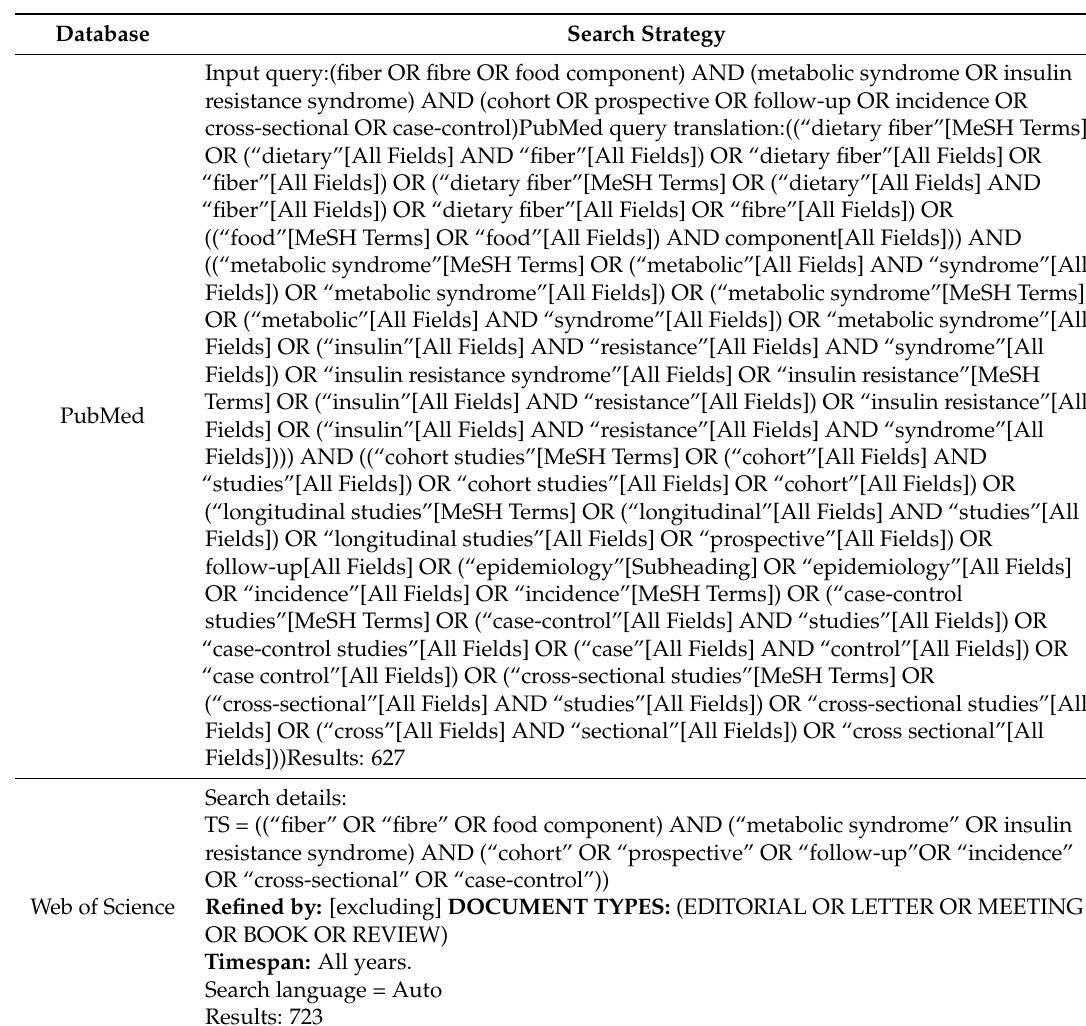
Table A1. Database search